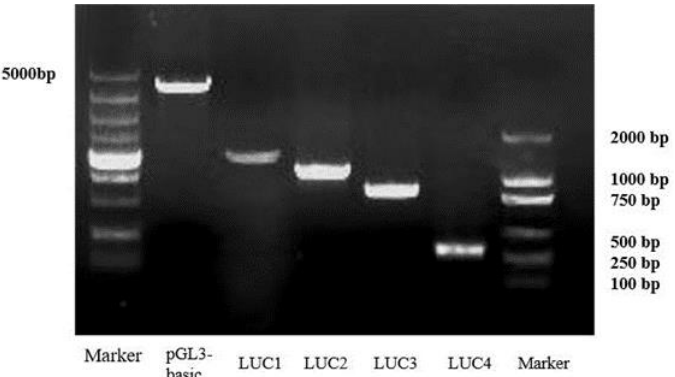
Figure 7. Sequence analysis and fragment amplification of IAG promoter in P. monodon . Bioinfor- matic prediction of potential cis-regulatory elements of transcription factors within the IAG gene promoter of P. monodon . Binding sites for binding various transcription factors are underlined, trans- lation initiation sites are circled by boxes, and Dsx binding sites are shaded in gray.